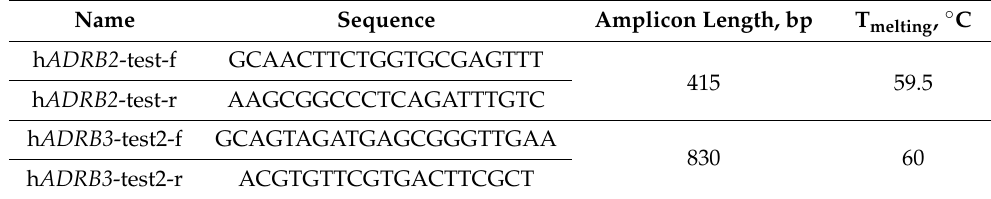
Table 1. Primers, used for the amplification of the target DNA site within the range of